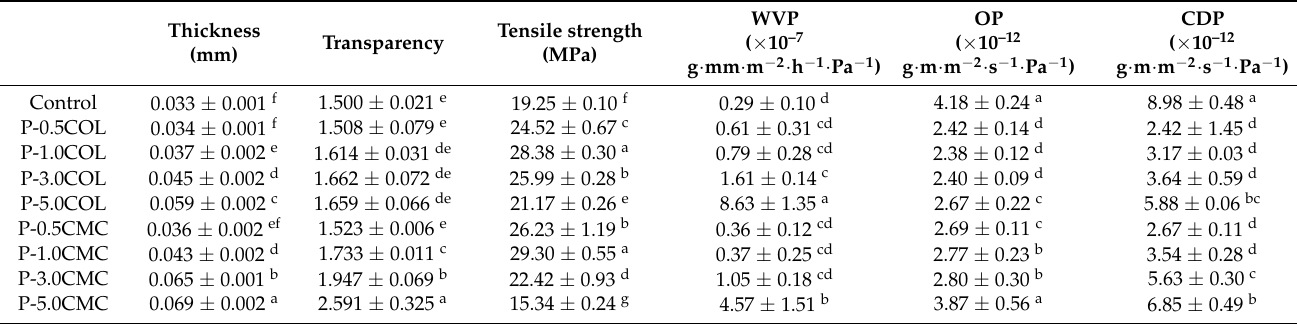
Table 1. Mechanical properties of different